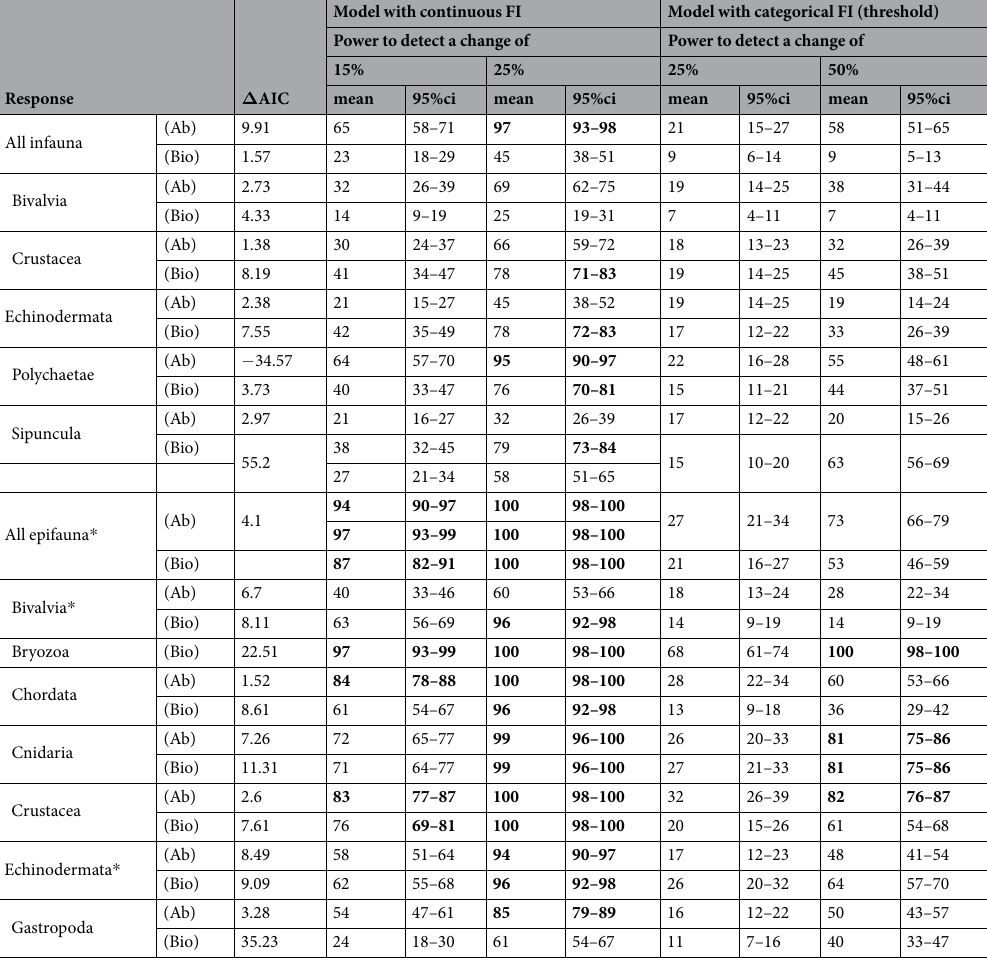
Table 4. Comparison of detection power of models with continuous or categorized (threshold) fishing intensity (FI) as a predictor variable. Δ AIC is the difference in AIC between models using continuous FI as a predictor versus the threshold approach. A positive value means that the best model was the threshold model. The power to detect a decrease of 15% and 25% per dredge pass with the continuous FI approach is reported for α = 0.1, as well as the power to detect a decrease of 25% and 50% with the threshold approach. The values in bold are the values which exceed a power of